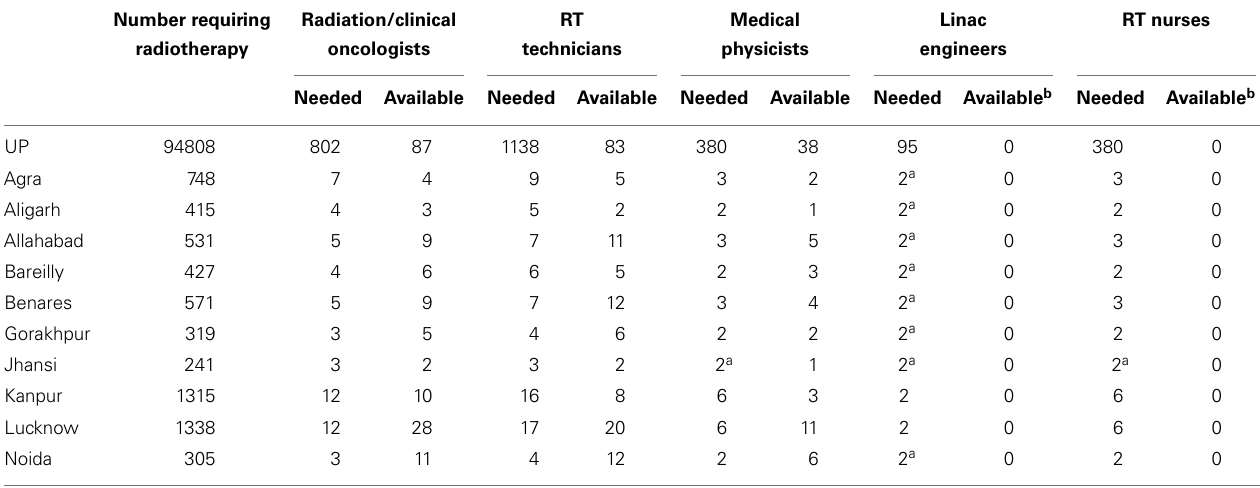
Table 5 | Radiation therapy (RT) staff needed versus available for UP and its 10 cities with radiation therapy centers based upon GLOBOCAN 2008 data